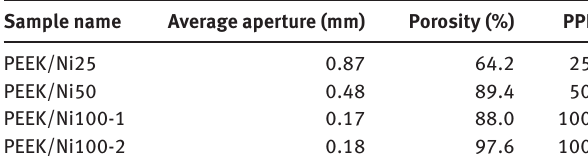
Table 1: Characteristic parameters of Ni foams.